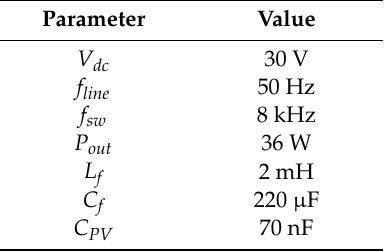
Figure 10. Simulated results of proposed inverter; ( a ) V AN , ( b ) V BN , and ( c ) V t , CM . Table 2. System parameters.